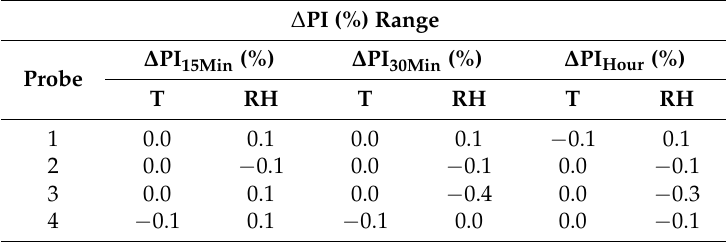
Table 4. Differences between reference PI MINUTE(range) values (Table 3) and PI obtained with datasets associated with extractions every 15 min, every 30 min, and every hour. The Performance Index is defined as the percentage of T and RH values that fall inside the range recommended in the UNI 10829:1999 standard for the conservation of paper. The differences ∆ PI 15Min , ∆ PI 30Min and ∆ PI Hour are calculated as (PI 15Min – PI MINUTE ), (PI 30Min – PI MINUTE ), and (PI Hour – PI MINUTE ), respectively.